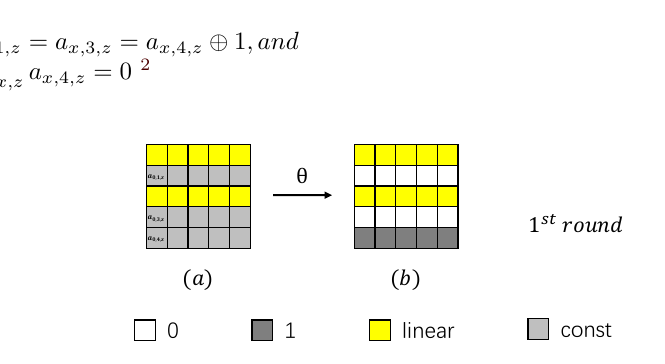
Figure 3: The inner states about θ operation in the first round.